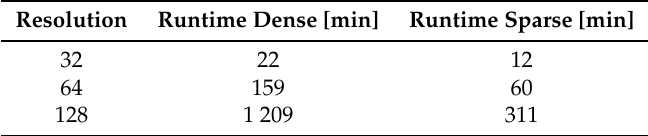
Table 3. Total simulation runtimes for different level-set resolutions using the dense and sparse approach.